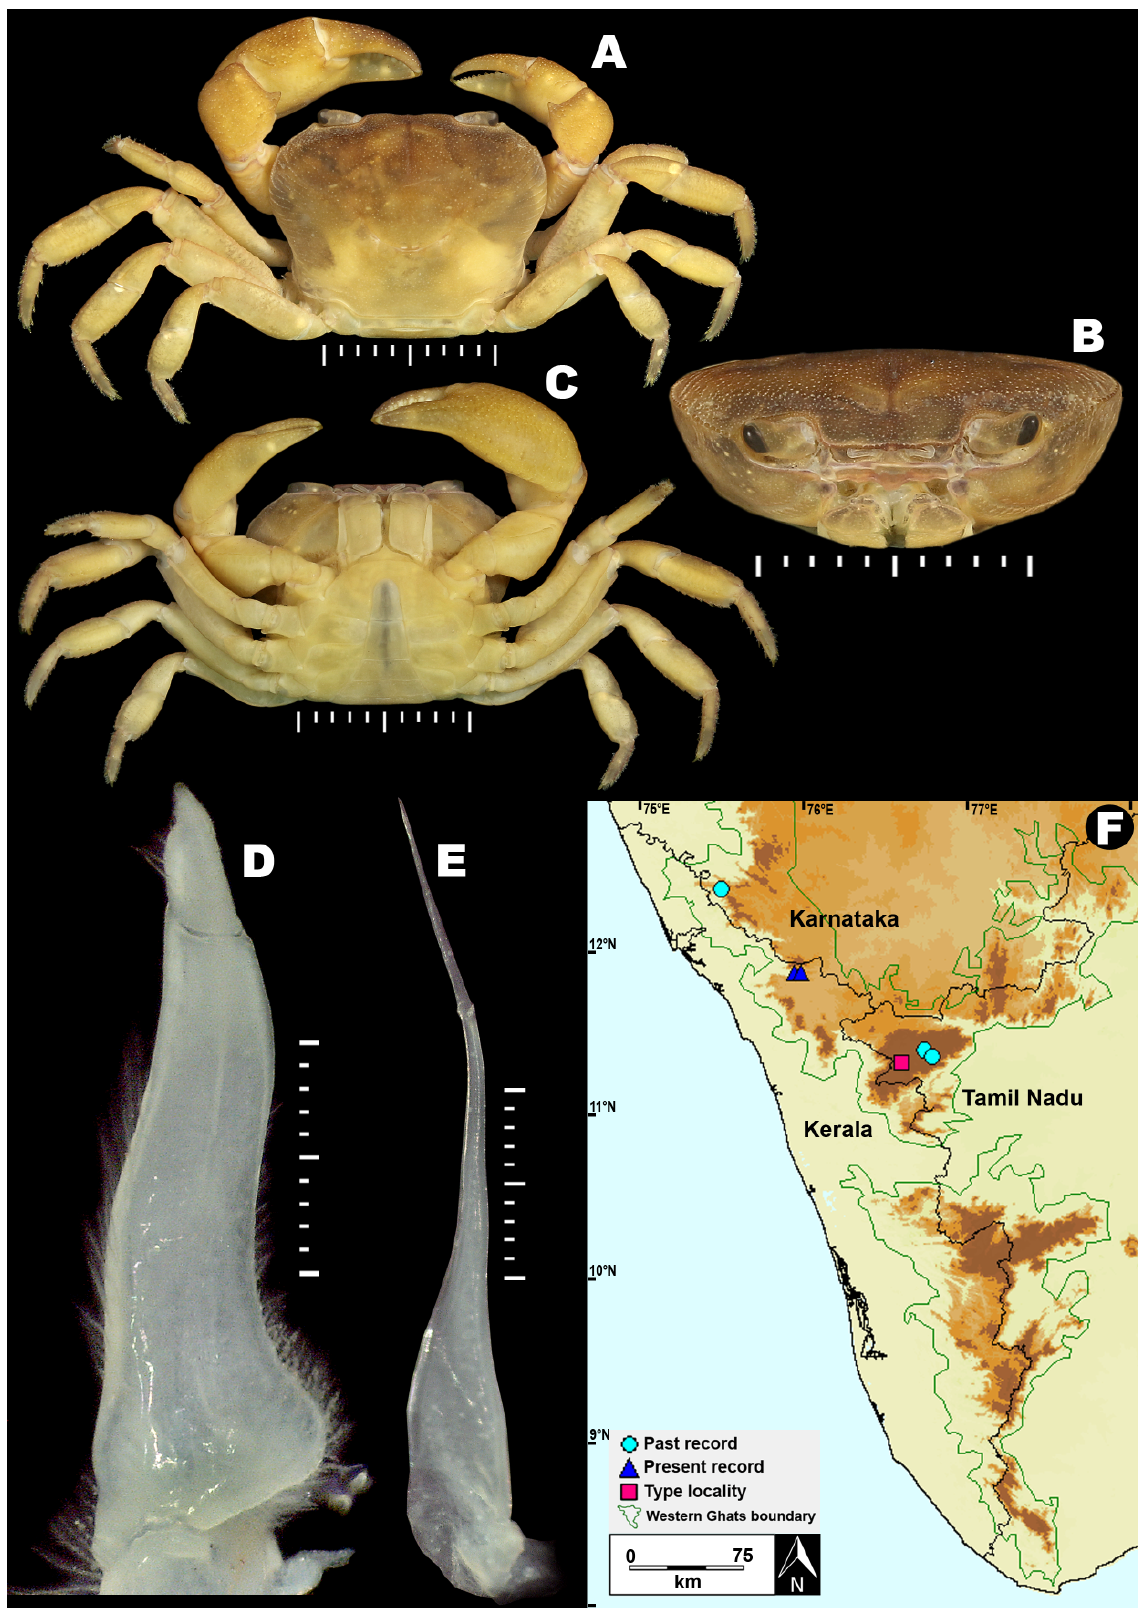
Figure 2. Vanni nilgiriensis (Roux, 1931), male (15.56 × 11.35 mm) (ZSI-WRC C.1825). A, overall dorsal view; B, frontal view of cephalothorax; C, overall ventral view; D, dorsal view of left G1; E, left G2; F, map showing distribution of V. nilgiriensis in the Western Ghats. Scale bar = 10 mm (A–C), 1 mm (D,